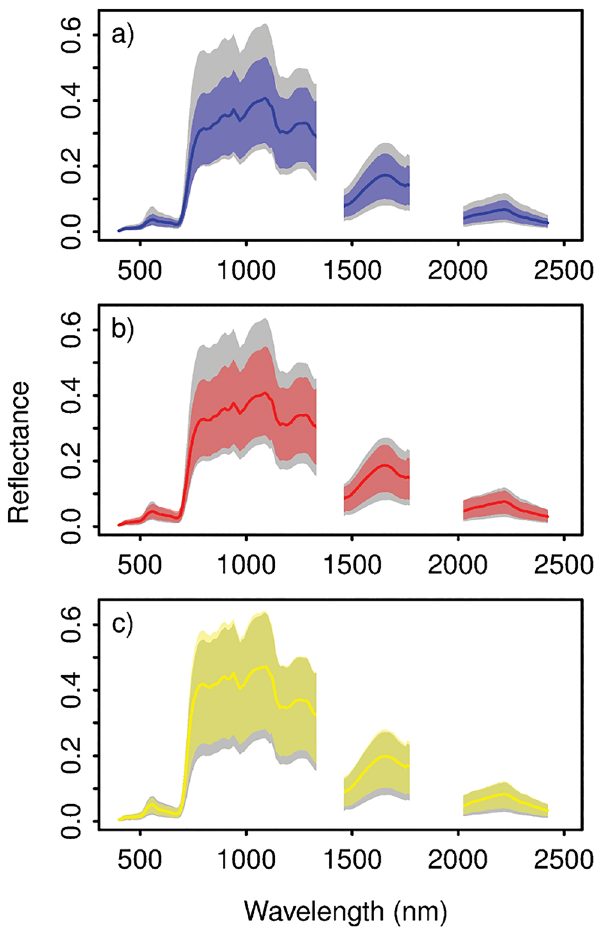
Fig 2. Mean and 95% confidence interval of the reflectance spectra for each focal species. (a) Dipteryx panamensis , (b) Handroanthus guayacan , and (c) Jacaranda copaia . The colored lines represent the mean reflectance, and the colored areas represent the 95% confidence interval for each spectral band. The gray area represents the 95% confidence interval for the well-lit leafy vegetation on BCI.